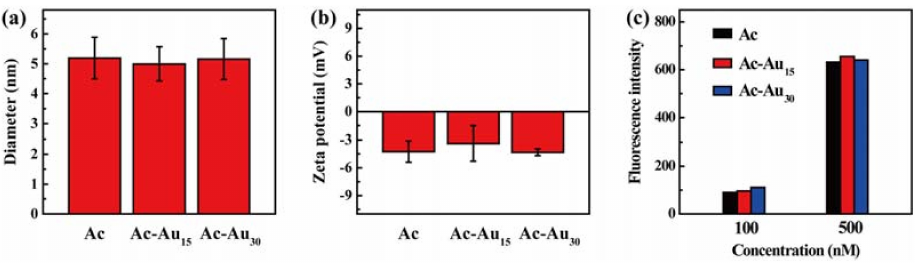
Figure 3. Hydrodynamicsize( a ),surfacepotential( b ),andfluorescenceintensity( c